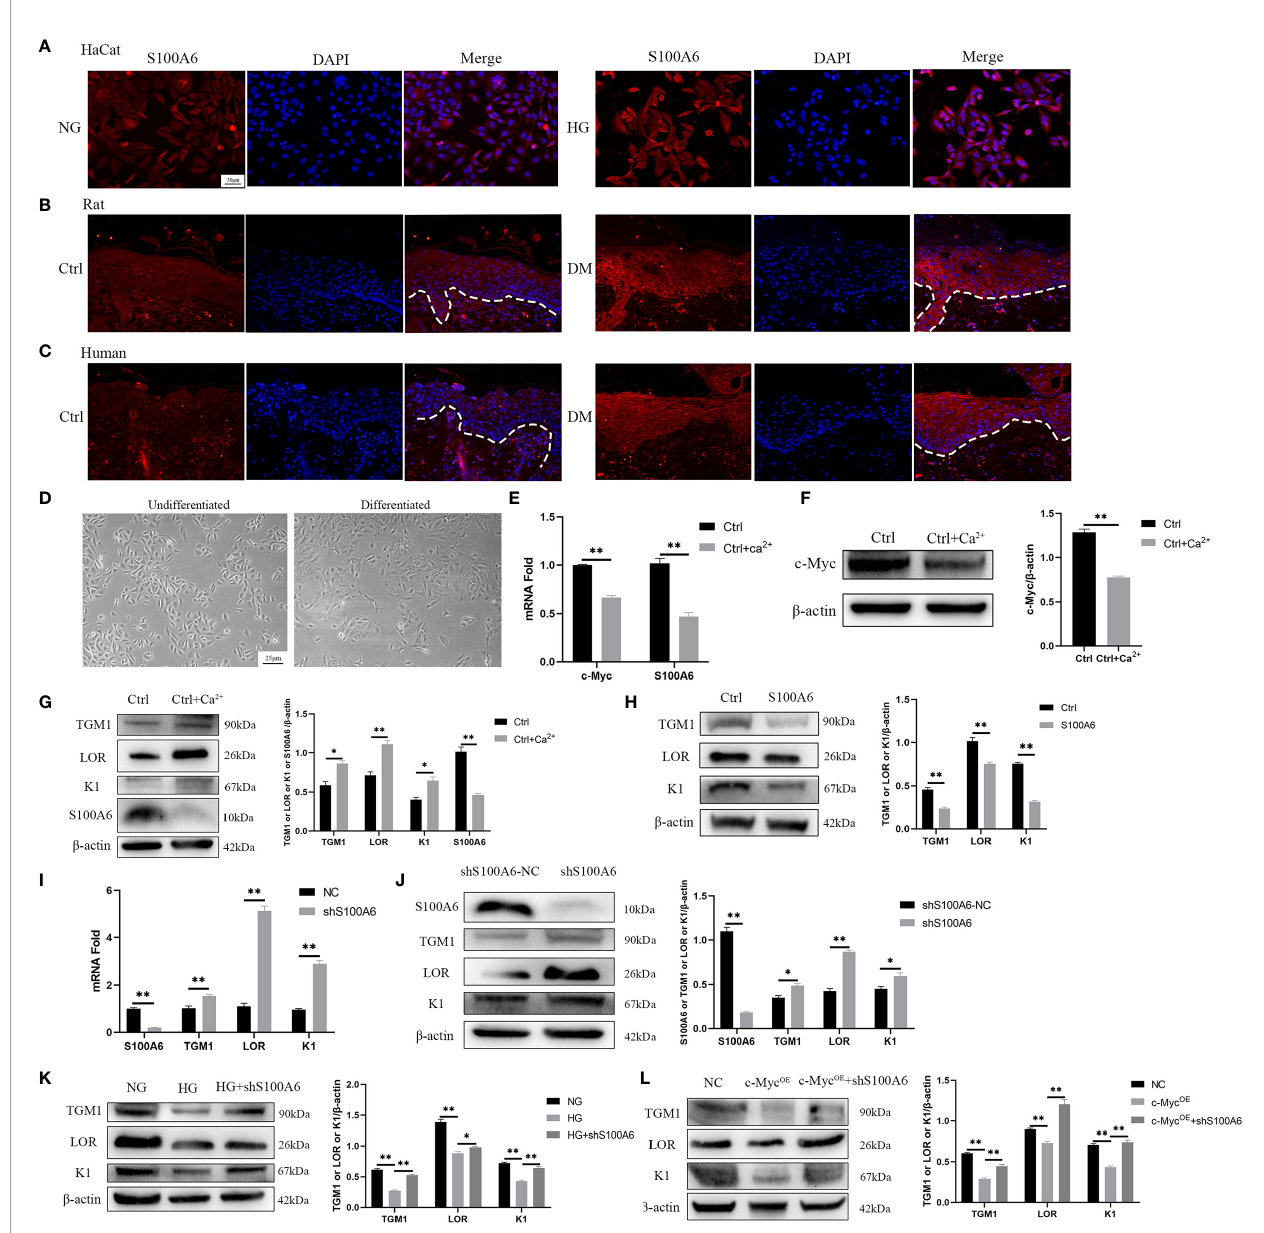
FIGURE 6 | S100A6 inhibits HaCaT differentiation (A – C) The expression of S100A6 was determined by immuno fl uorescence assay in HaCaT cells (A) or wound margin tissues of rats (B) and humans (C) . The nuclei were stained blue using DAPI. Magni fi cation: ×200, Scale bar =50 m m. The white dotted line represents the epidermis-dermis dividing line. (D) Morphology of undifferentiated and differentiated HaCaT cells was recorded. Magni fi cation: ×100, Scale bar =25 m m. (E – G) The mRNA and protein expressions of c-Myc and S100A6 and protein expressions of TGM1, LOR and K1 were detected after the differentiation of HaCaT cells. (H) HaCaT cells was pre-treated with S100A6 recombinant protein (1 m M) for 24h and then TGM1, LOR and K1 protein levels were measured. (I, J) The mRNA and protein levels of TGM1, LOR, and K1 were determined after knocking down S100A6 in HaCaT cells. (K) TGM1, LOR, and K1 expression levels were determined in S100A6 -knockdown HaCaT cells cultured with high glucose. (L) TGM1, LOR, and K1 expression levels were determined in HaCaT cells overexpressing c-Myc or meanwhile knocking down S100A6 . shS100A6-NC, the negative control of S100A6 knockdown. NC, negative control. Data were shown as the mean ±